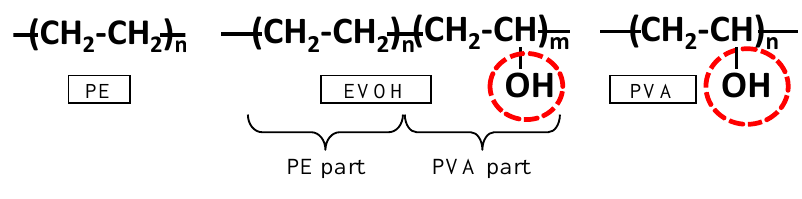
Figure 1. Characteristic part of chemical components.